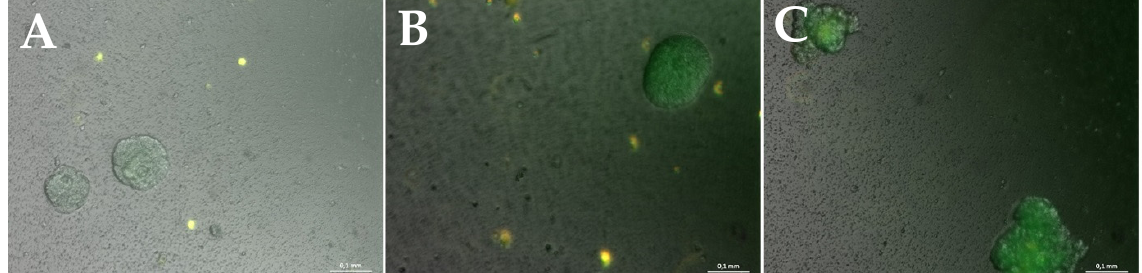
Figure 4. Merged brightfield, GFP and DsRed fluorescent pictures of a presentative hydrogel culture. GFP-positive microtumor-spheroids can be observed over the entire cultivation time, and grow in size. Additionally, RFP-positive fibroblasts exhibiting a roundish shape can be detected. ( A ): After 7 days of cultivation. ( B ): After 14 days of cultivation. ( C ): After a cultivation time of 21 days. Measuring bar: 100 µm. Table 3. Optimal cell numbers to integrate into the miniaturized hydrogel in a total volume of 50 µ L.